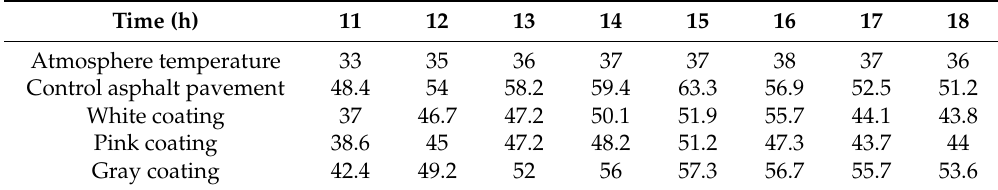
Table 6. Measured temperature of pavement surface with different coating ( ◦